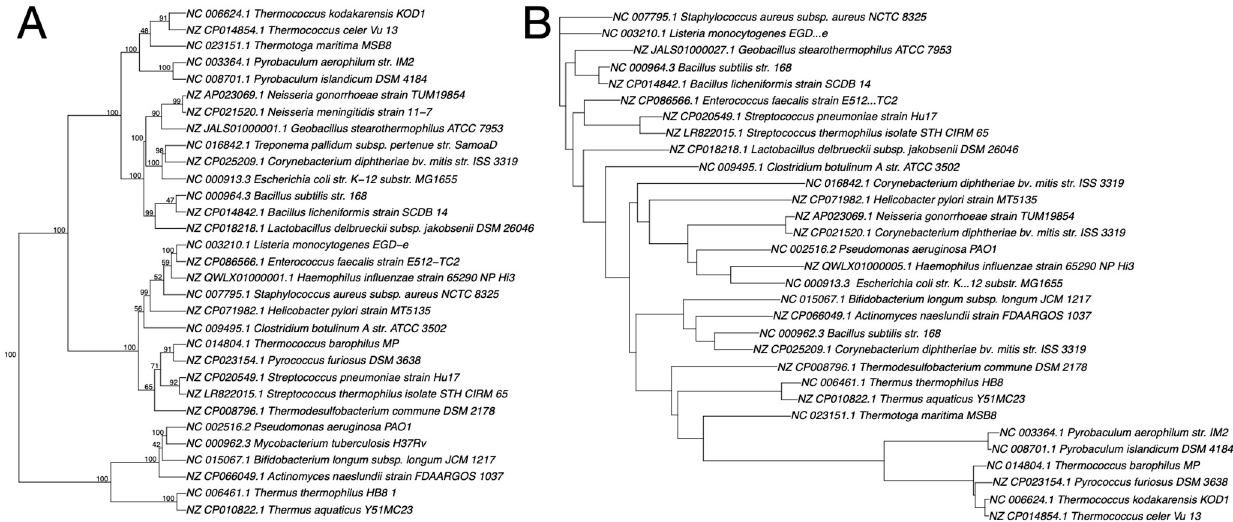
Fig 6. Phylogenetic trees of various distantly related species including archaea and bacteria, based on pentanucleotide frequencies (A) and 16S rRNA gene sequences (B). The trees were constructed using the Manhattan distance and Ward’s algorithm (A) or the neighbor-joining method (B). The numbers at the nodes indicate the percentage occurrences among 1,000 bootstrap values. Separated groups of species are highlighted.